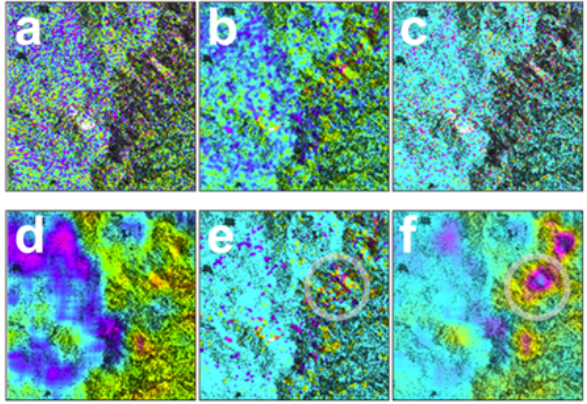
Figure 4. Imari area: effects of filter application to InSAR outcome for the Imari area. Circles indicate areas of landsliding. (a) InSAR result, (b) median filtering, (c) histogram extraction (upper 20% ex- tract of the normalised displacement), (d) Laplacian filter, (e) me- dian filtering and histogram extraction, (f) median filtering and his- togram extraction and Laplacian filter.